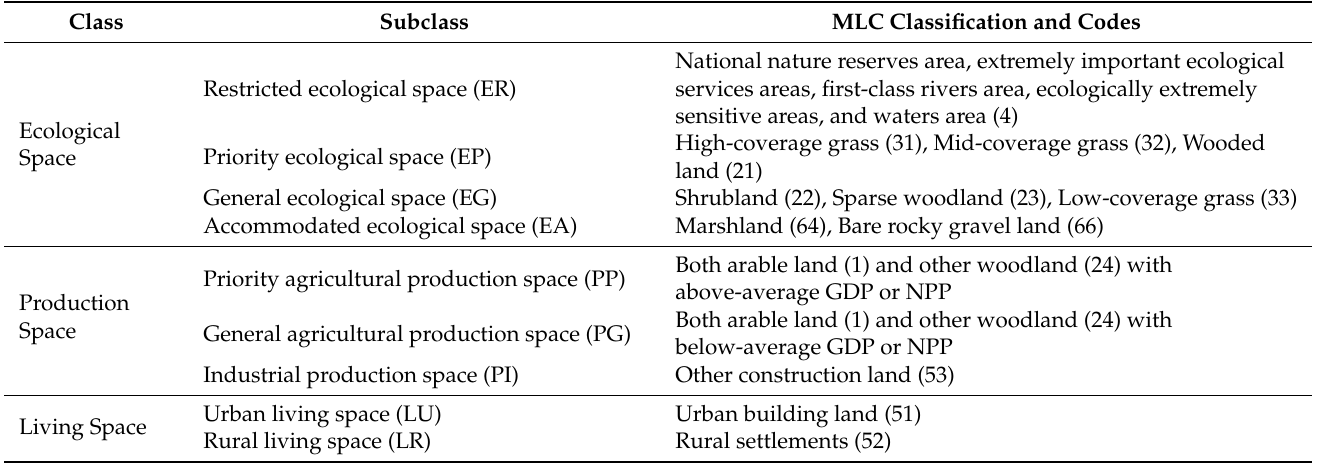
Table 2. Relationship between the classification system of PLE spaces and MLC